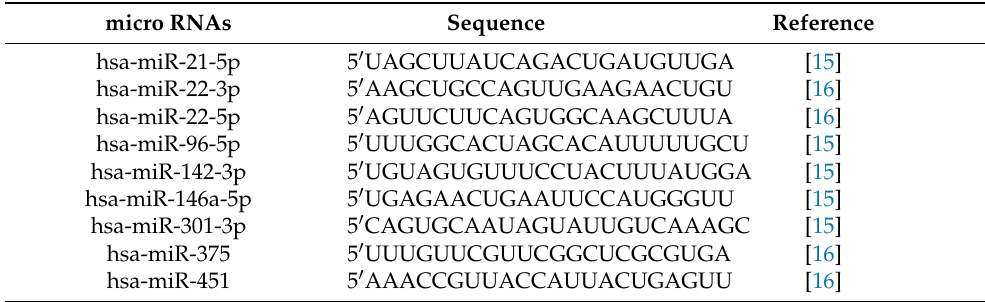
Table 1. MiRNAs, mature sequence and source of reference of each selected miRNA. micro RNAs